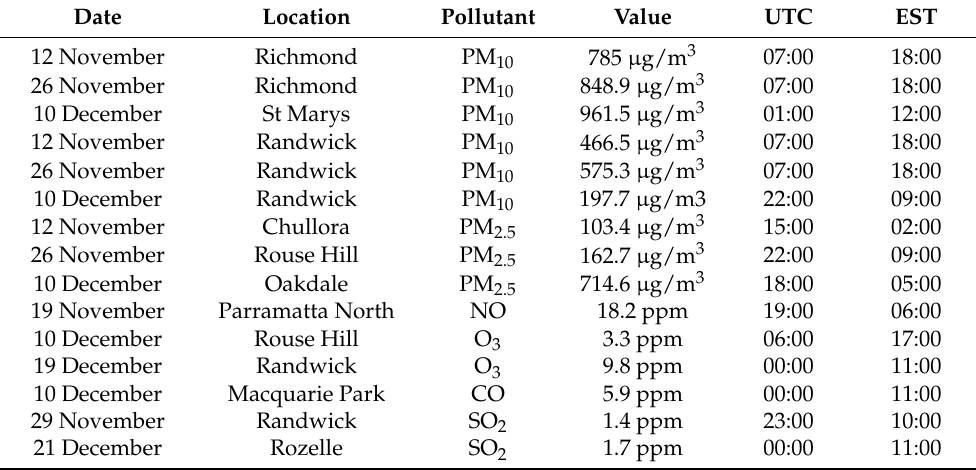
Table 1. Maximum hourly average pollutant loadings at selected sites in the Sydney region caused by the 2019–2020 Blue Mountains bushfires. UTC = Coordinated Universal Time; EST = Australian Eastern Standard